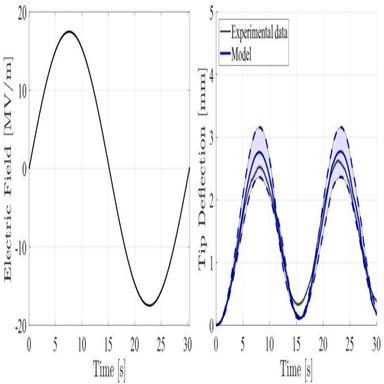
Time transient experimental and model tip deflection when a sinusoidal electric field input is applied to (at least) three soft actuators with transversally aligned nanofibers integrated in PDMS. The blue shaded areas represent the simulation results with the relative permittivity values spanned between 9 and 12, while the gray shaded areas represent the standard deviation on the electromechanical characterization.